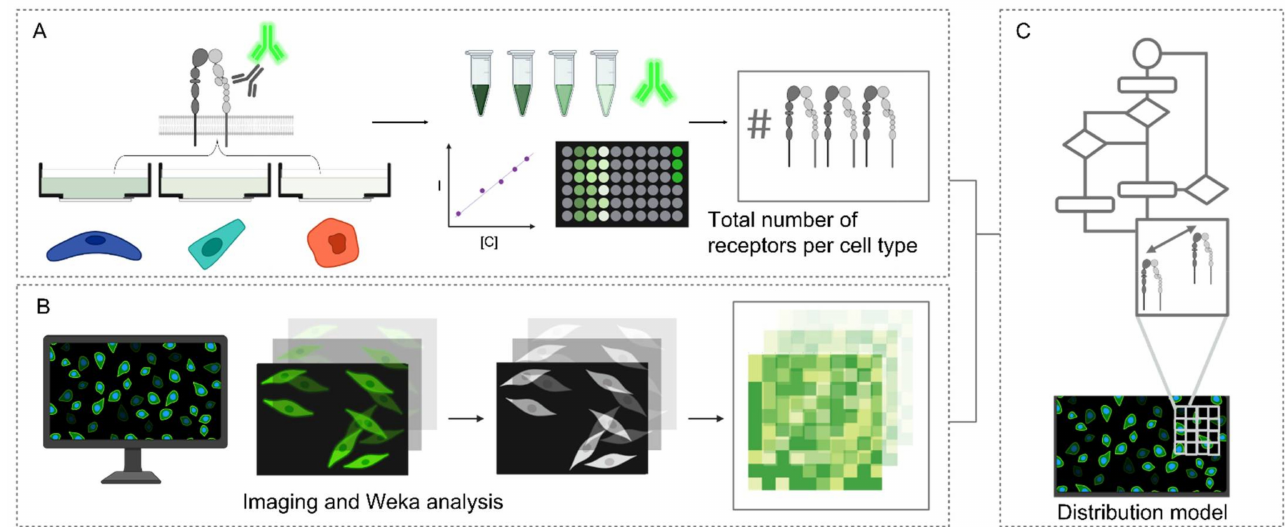
Figure 2. Workflow in modeling integrin α 5 β 1 receptor distributions in HUVEC, CHO and HeLa. ( A ) Immuno-staining assay and subsequent comparison with a calibration curve to calculate total number of receptors ( B ) Fluorescence microscopy and image processing by Weka analysis ( C ) Mathe- matical model of integrin α 5 β 1 distribution of interreceptor